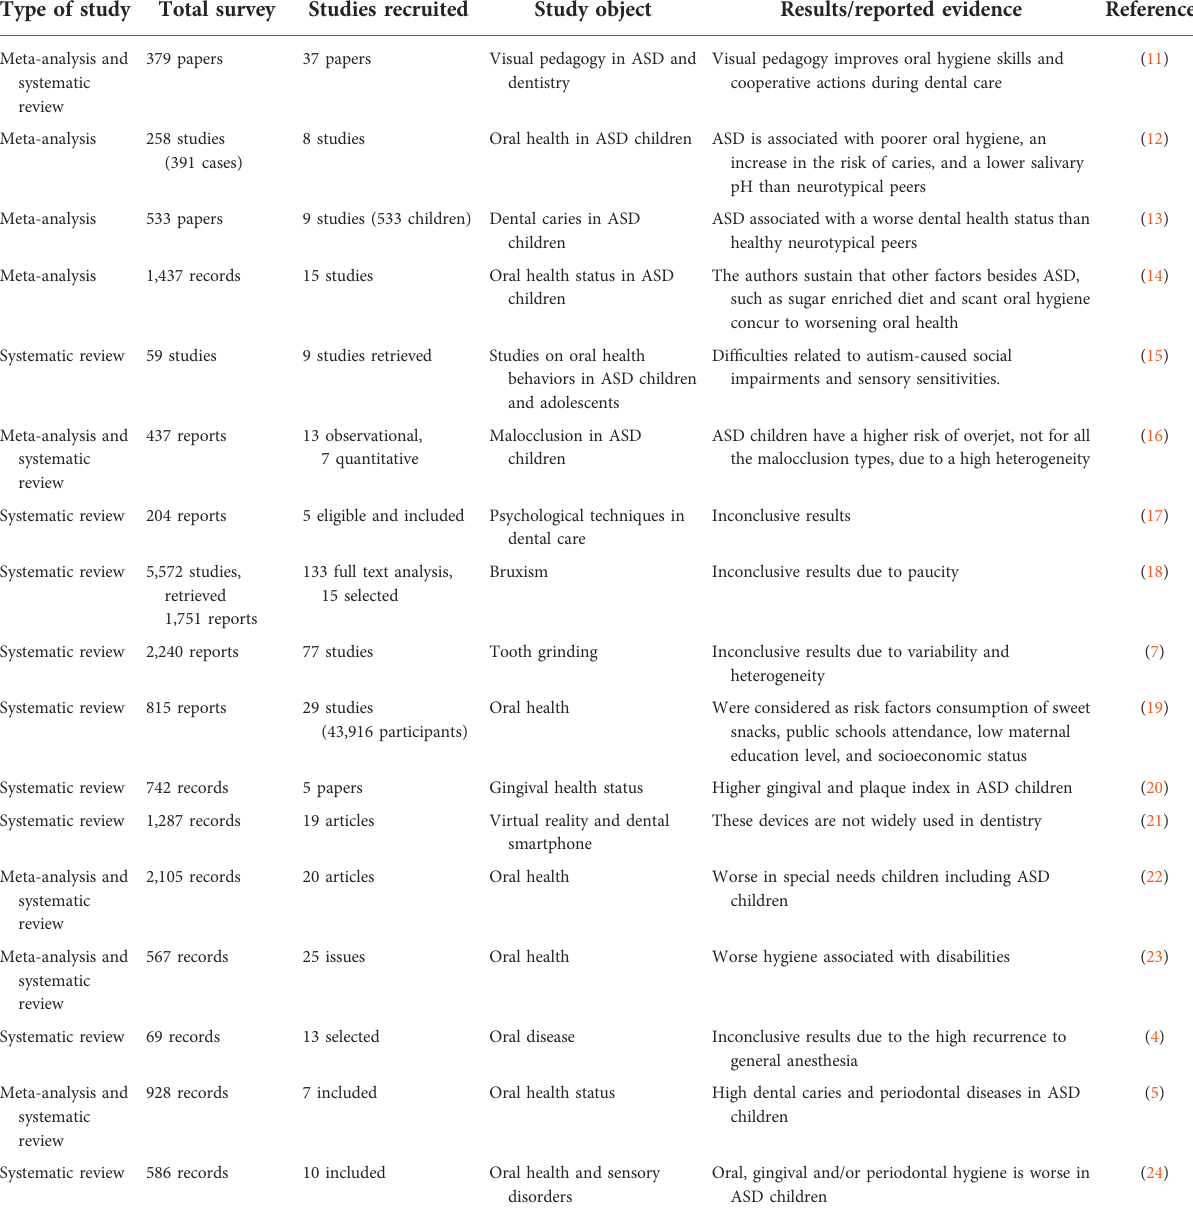
TABLE 1 Recent meta-analyses and systematic reviews on dentistry/oral health in